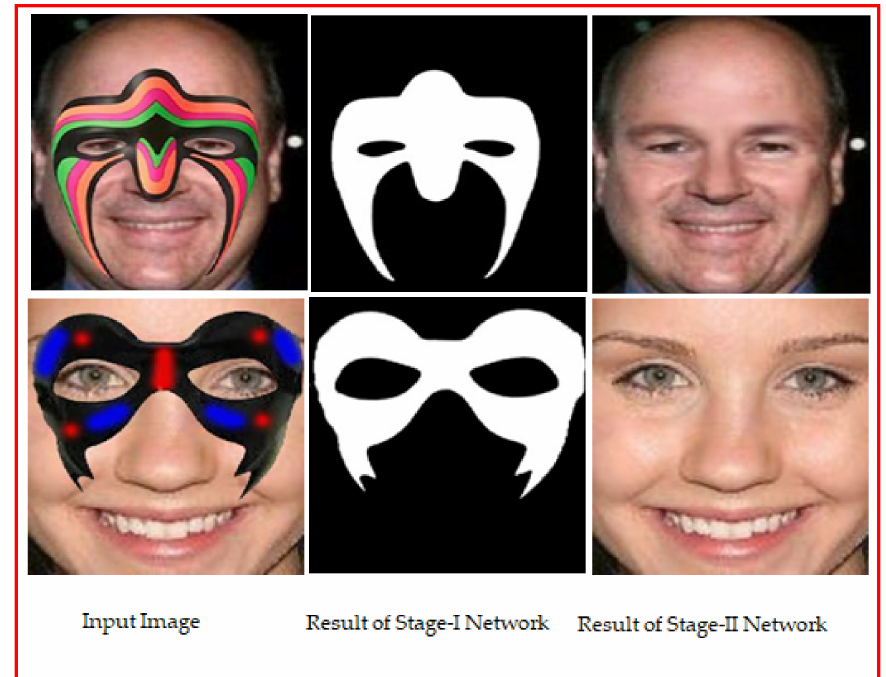
Figure 1. The proposed AFD-StackGAN results on real-world